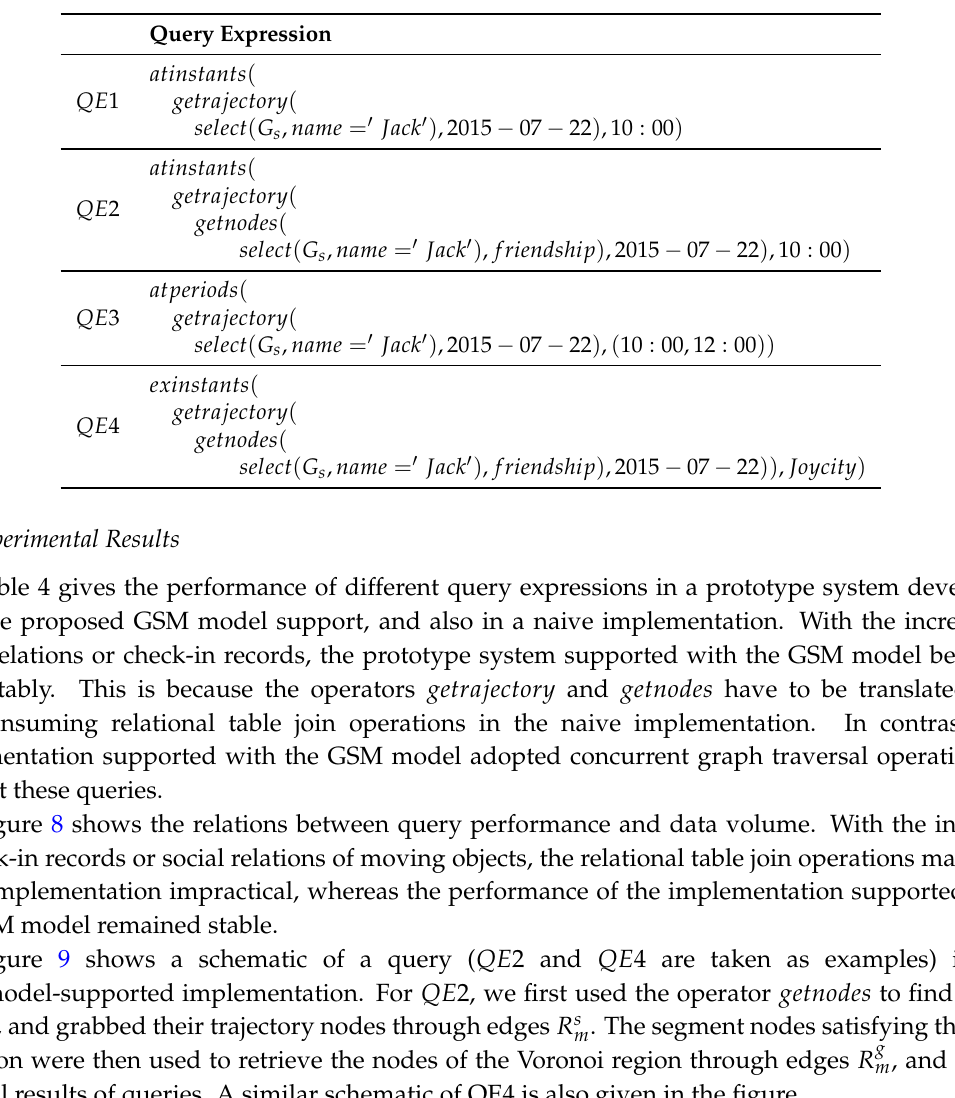
Table 3. Tested query expressions for the GSM